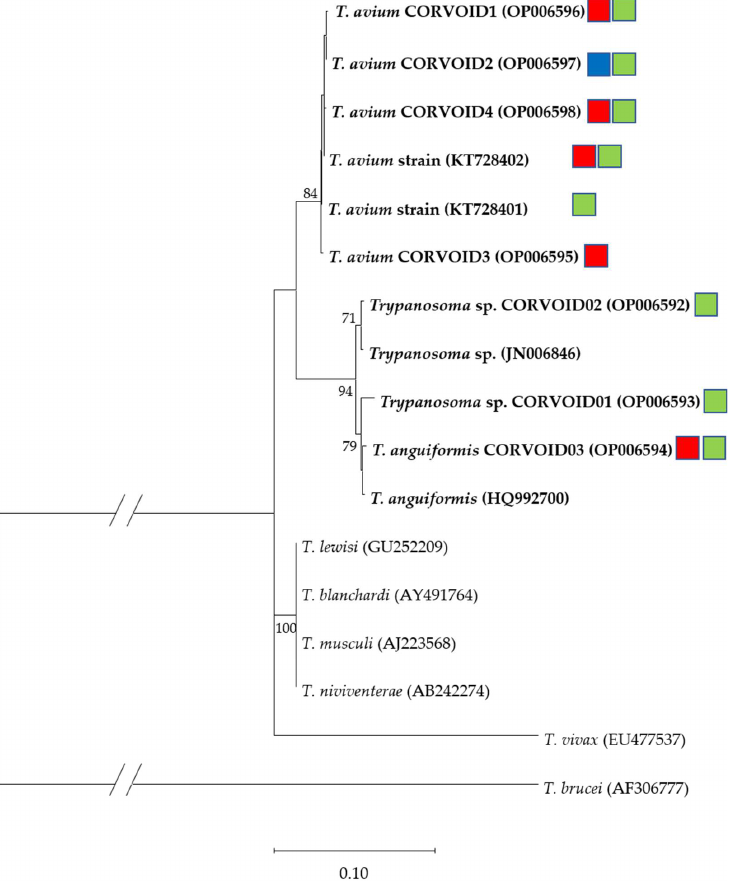
Figure 5. Phylogenetic relationship of Trypanosoma SSU rRNA sequences (Acc. No.) detected in Corvoidea species on Madagascar, along with highly homologous previously published sequences (Acc. No.) constructed using maximum likelihood (K2 + G). Bootstrap values >70% are given. Bold text indicates sequences exclusively isolated from birds. Bird families from which the lineages were isolated are indicated with color-coded squares. Red = Monarchidae; blue = Dicruridae; green = Van- gidae.